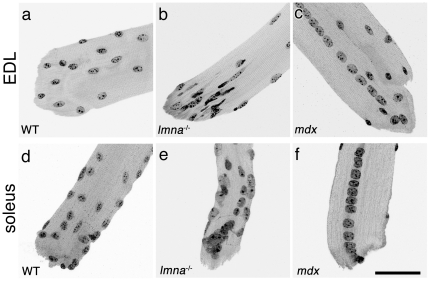
Myonuclei cluster at the myotendinous junctions of lmna−/− myofibres.DAPI staining at the myotendinous junction from wild-type (WT) lmna+/+ EDL and soleus myofibres show that myonuclei are evenly distributed, with similar shape, size and chromatin organization (a and d). Myonuclei tend to cluster at the myotendinous junction from lmna
−/− mice, and are unevenly distributed with varying sizes, shapes and condensed chromatin content (b and e). Myonuclei of the myotendinous junction from mdx mice have an overtly normal morphology, although often in centrally located chains that continue to the end of the myofibre (c and f). Scale bar 50 µm.